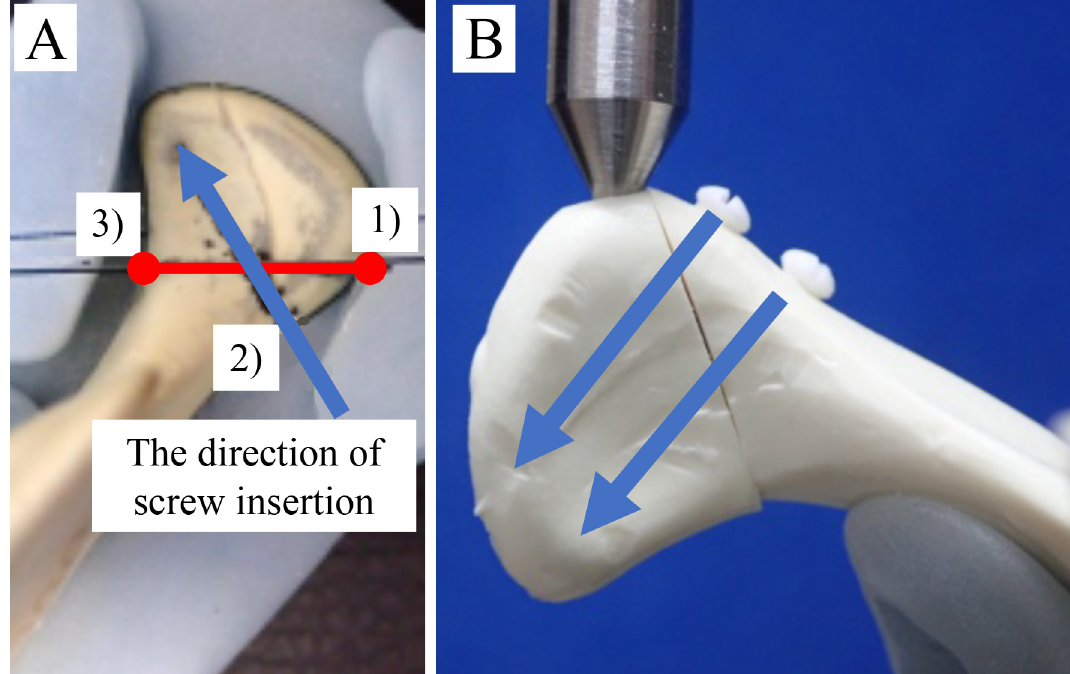
Figure 2. ( A ) A mandibular condylar head fracture type B model, using a fracture line that starts slightly outside the attachment of the lateral capsule and continues outside the condyle, was created as shown in Figure 1. 1) The upper end of the mandible condylar fracture line, 2) The medial inferior point of the fracture surface, and 3) The innermost point of the sagittal fragment. The direction of passing through the midpoint of points 1 and 2 toward 3 was the direction of screw insertion. ( B ) Double-screw fixation was moved parallel to the caudal side from this direction, and the other was inserted.